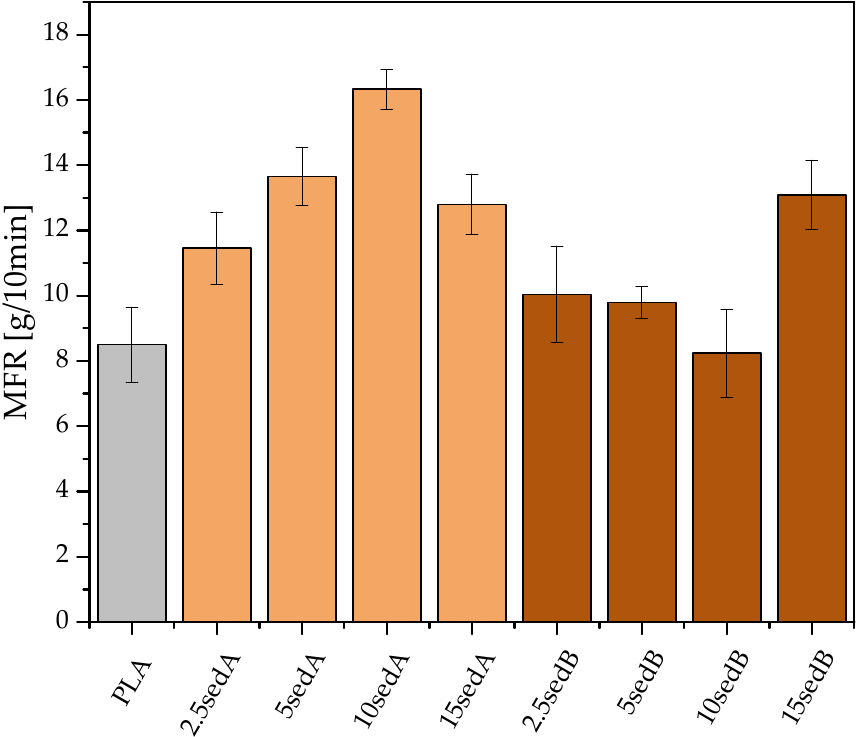
Figure 5. Results of the Mass Melt Flow Ratio